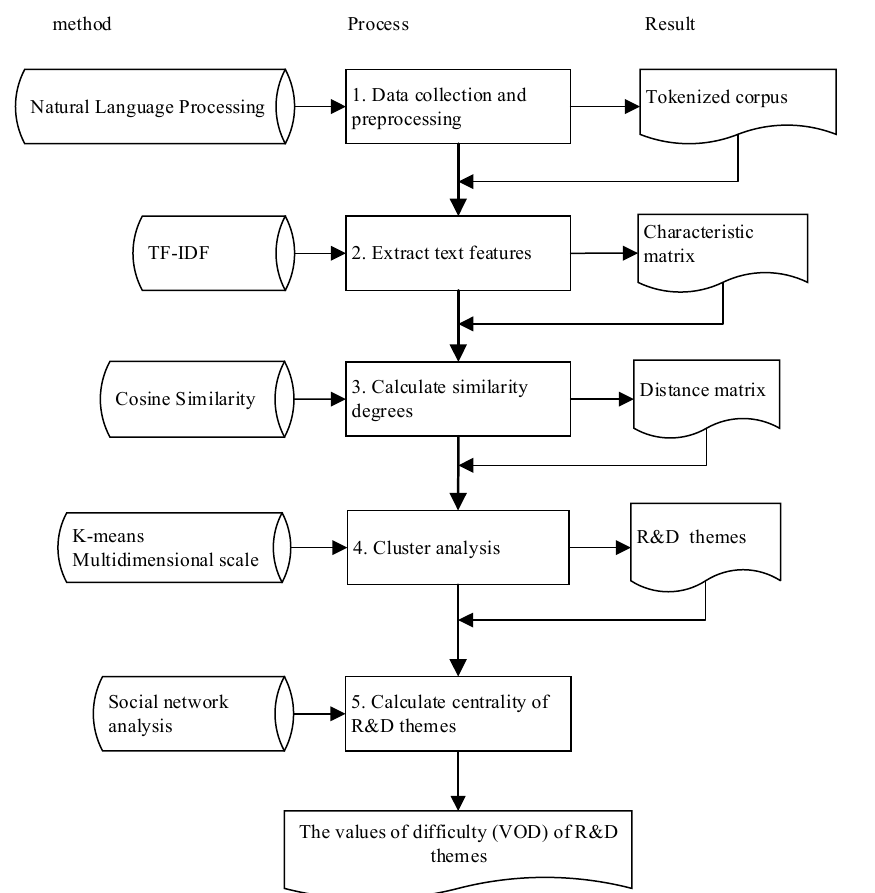
Figure 5. Workflow of the natural language process and cluster analysis of patent specifications.